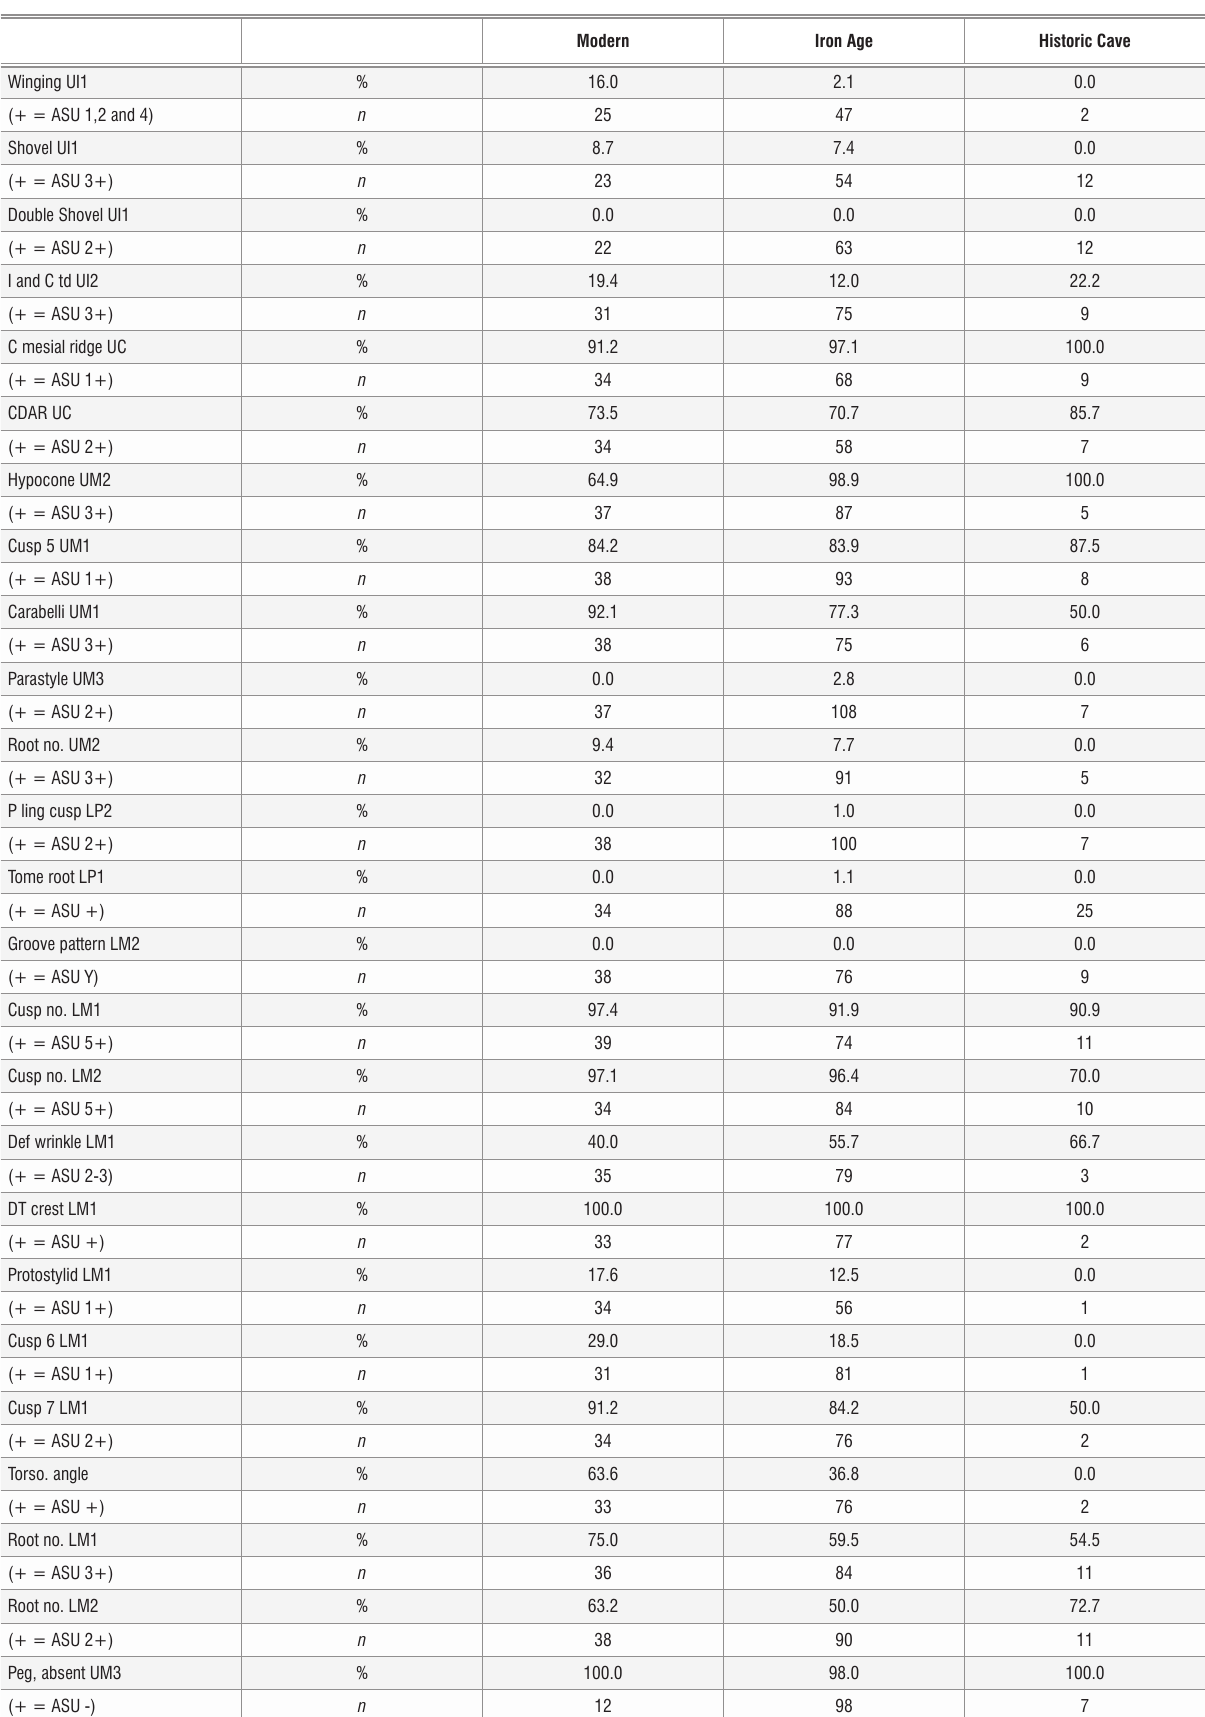
Table 3: Sample size and frequencies for each trait for each sample